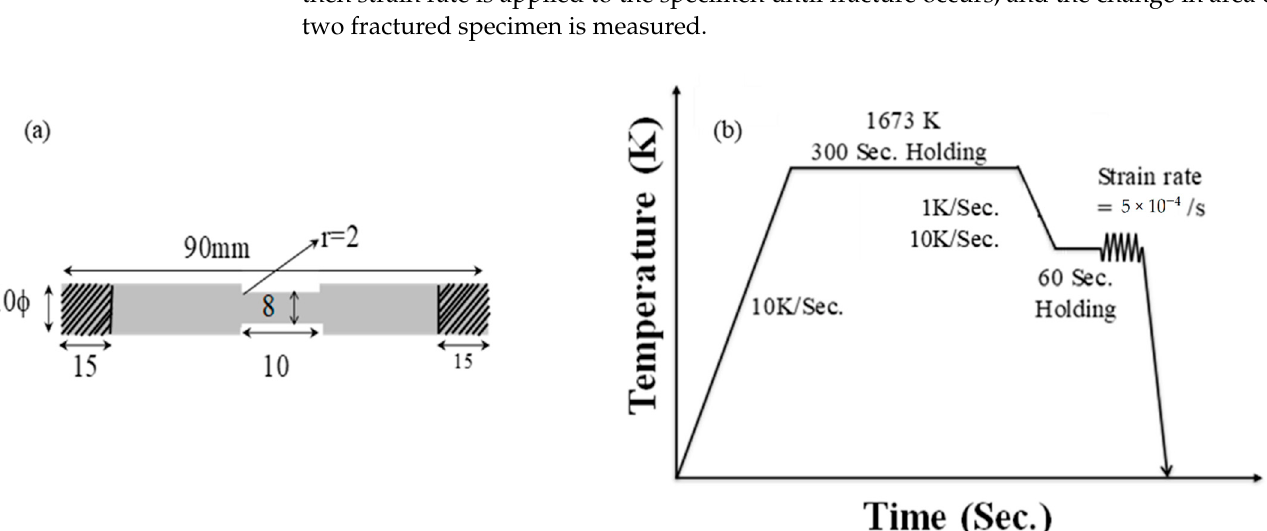
Figure 10. Comparison of RA behavior according to the cooling rate of Nb-added steel. Various alloying elements are added to steel to achieve high strength, weight reduc- tion, and thickening. When the cooling rate of a cast steel having the same composition is increased during continuous casting, a hard phase such as bainite or martensite forms in the steel structure, and the ductility of the steel decreases in the low temperature region